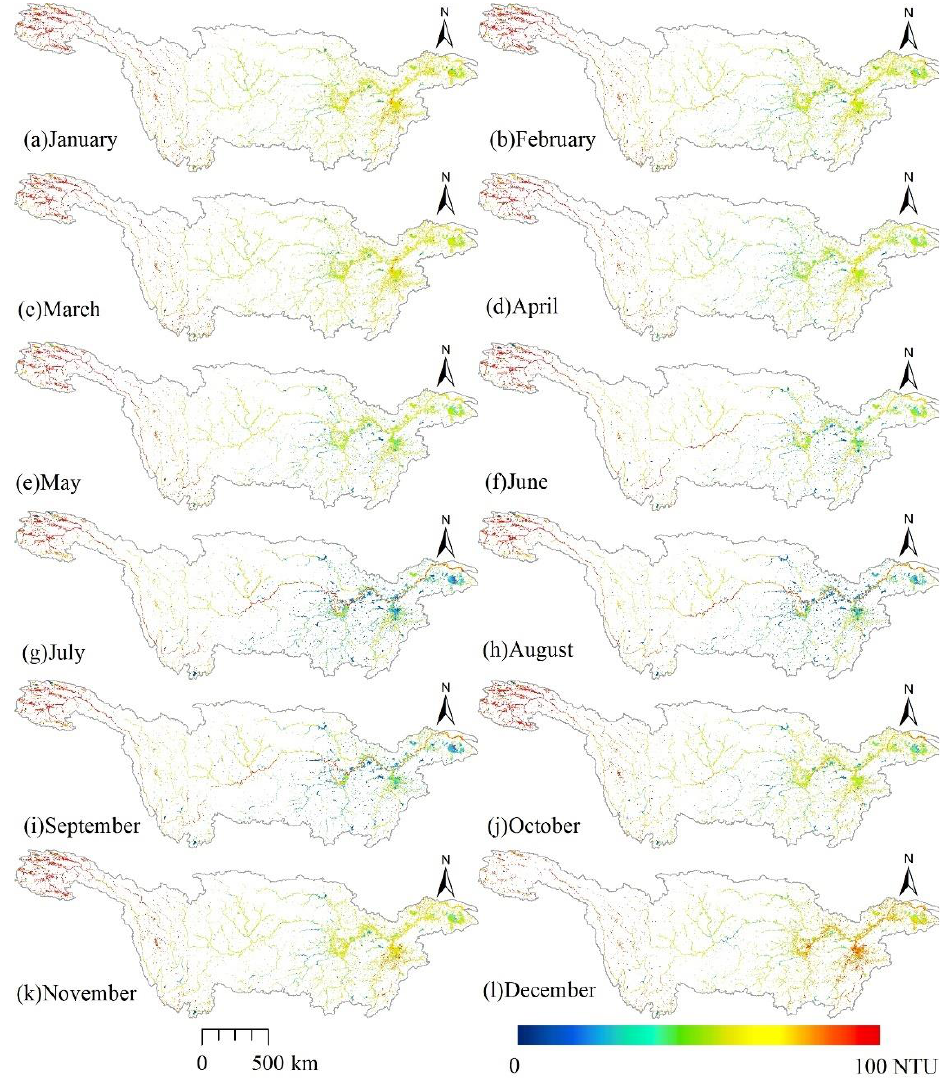
Figure 9. Monthly average turbidity distribution in the Yangtze River Basin from 1986 to 2021.